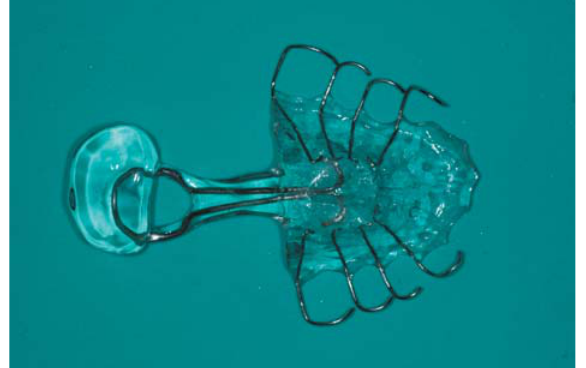
Figure 1- Pharyngeal obturator (speech bulb)